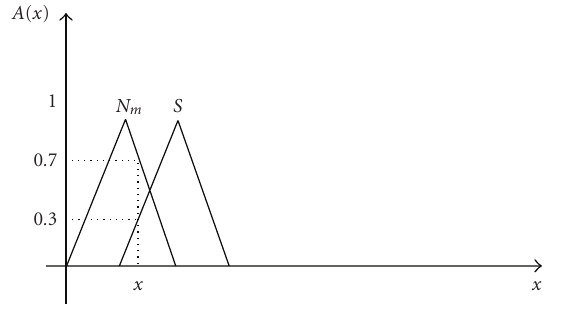
Figure 1: Fuzzy space for an object x consisting of two fuzzy sets: “Normal” and “Suspicious”.